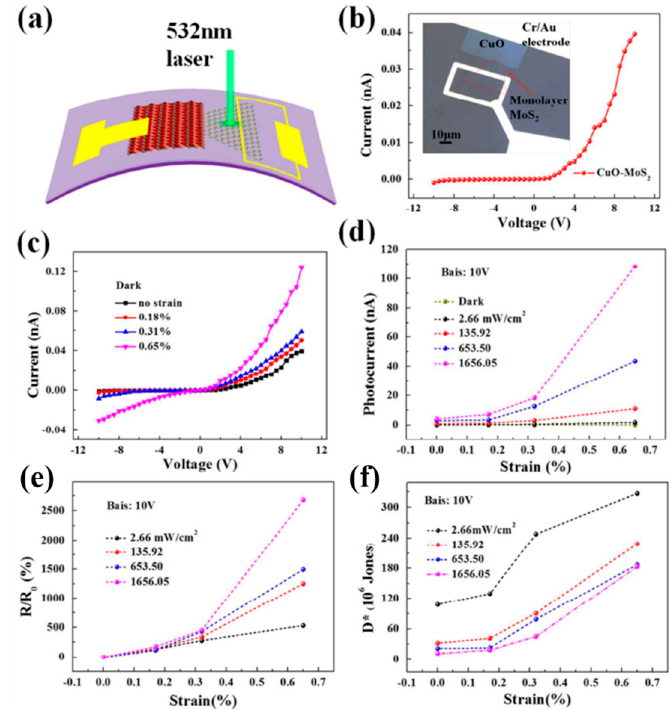
Figure 11. ( a ) The structure diagram of p-CuO/n-MoS 2 heterojunction PDs on the PET substrate. ( b ) I-V curve of p-CuO/n-MoS 2 heterojunction without strain in the dark. The inset is the optical image of the PD device. ( c ) I-V curves of the heterojunction with different tensile strains in the dark. ( d ) The strain dependence of the photocurrent. ( e ) The strain dependence of R/R 0 . ( f ) The strain dependence of detectivity with different power densities at a bias of 10 V [125].